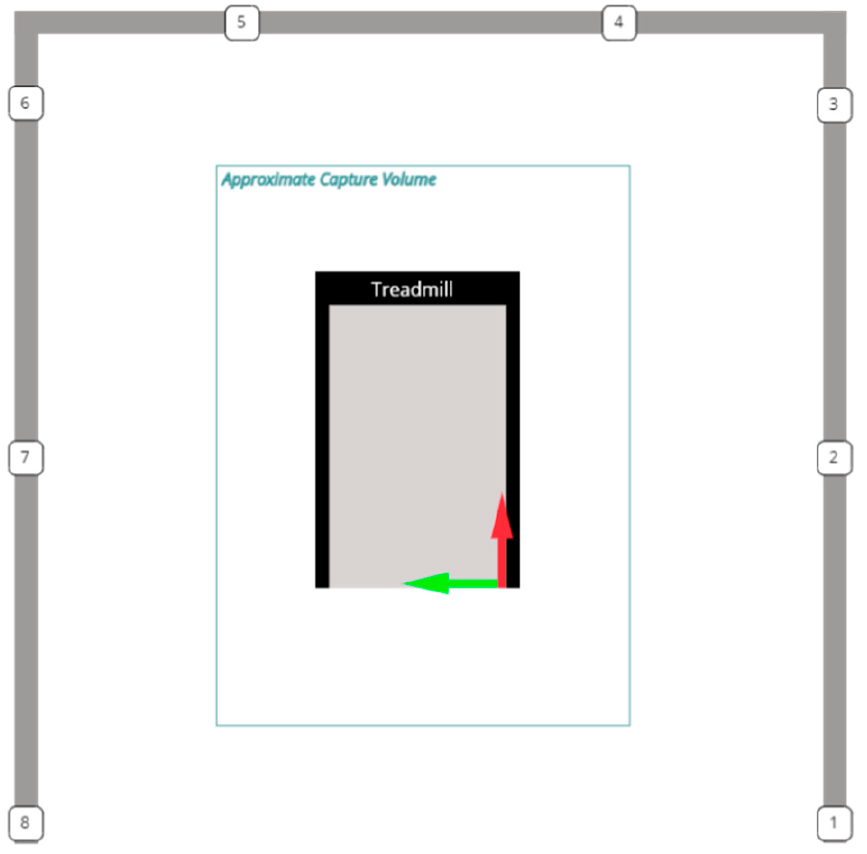
Figure 1. Eight synchronized Sony RXO II cameras (Sony Corporation; Minato, Japan) (120 Hz) were arranged on a truss 2.9 m from the floor in a horseshoe design (5.5 × 5.5 m) to establish a capture volume of approximately 2.4 × 2.4 × 3.1 m. A Noraxon PhysTread Pressure Treadmill (Noraxon USA; Scottsdale, AZ) was centrally located and the floor was marked so it could be placed in the same location for each testing